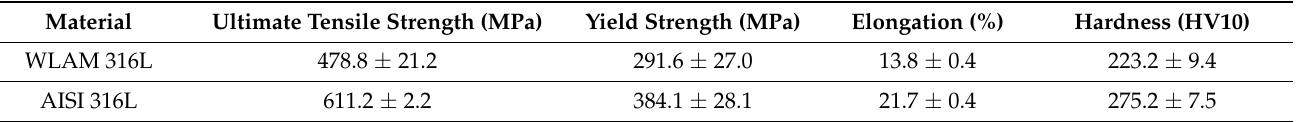
Figure 5. Stress–strain curves of the WLAM samples and the counterpart AISI 316L alloy. Table 3. Mechanical properties of the WLAM samples and the counterpart AISI 316L alloy.